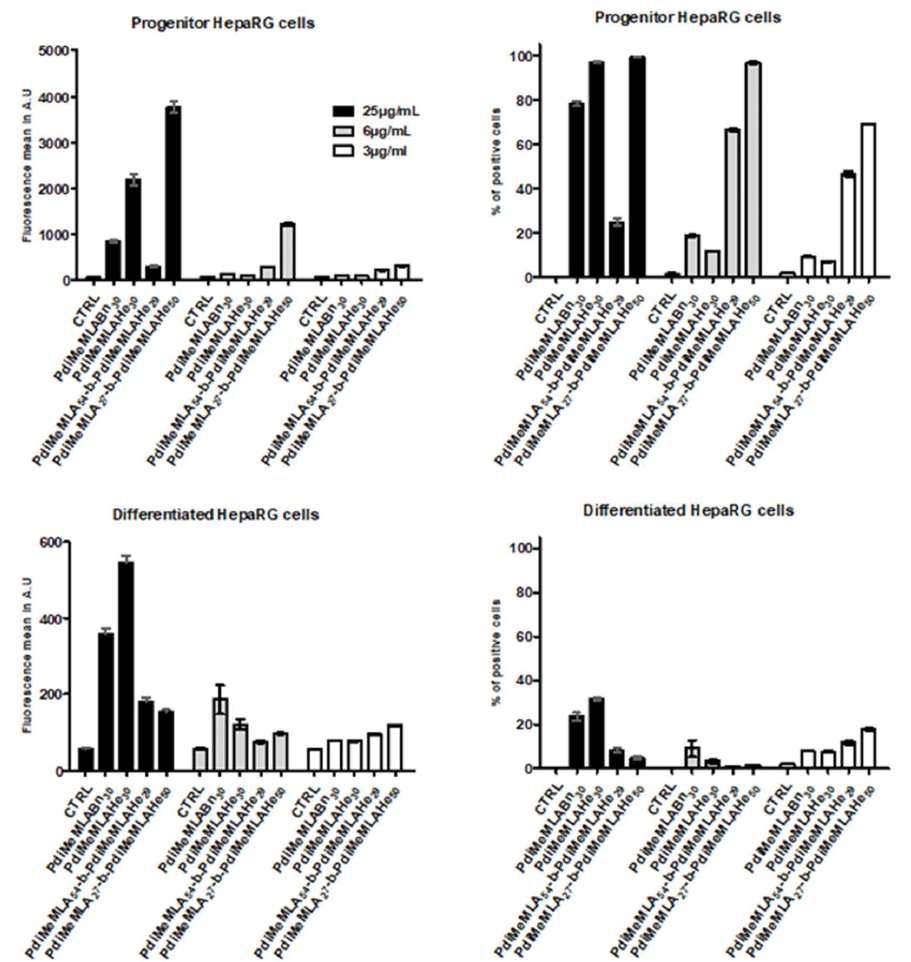
Figure 7. Progenitor and differentiated HepaRG cell viability evaluated by measuring the ATP content at 24 h of incubation with increasing concentrations of P 4 - t -Bu. Statistics: * p <0.05 for treated cultures versus untreated control cultures (0).